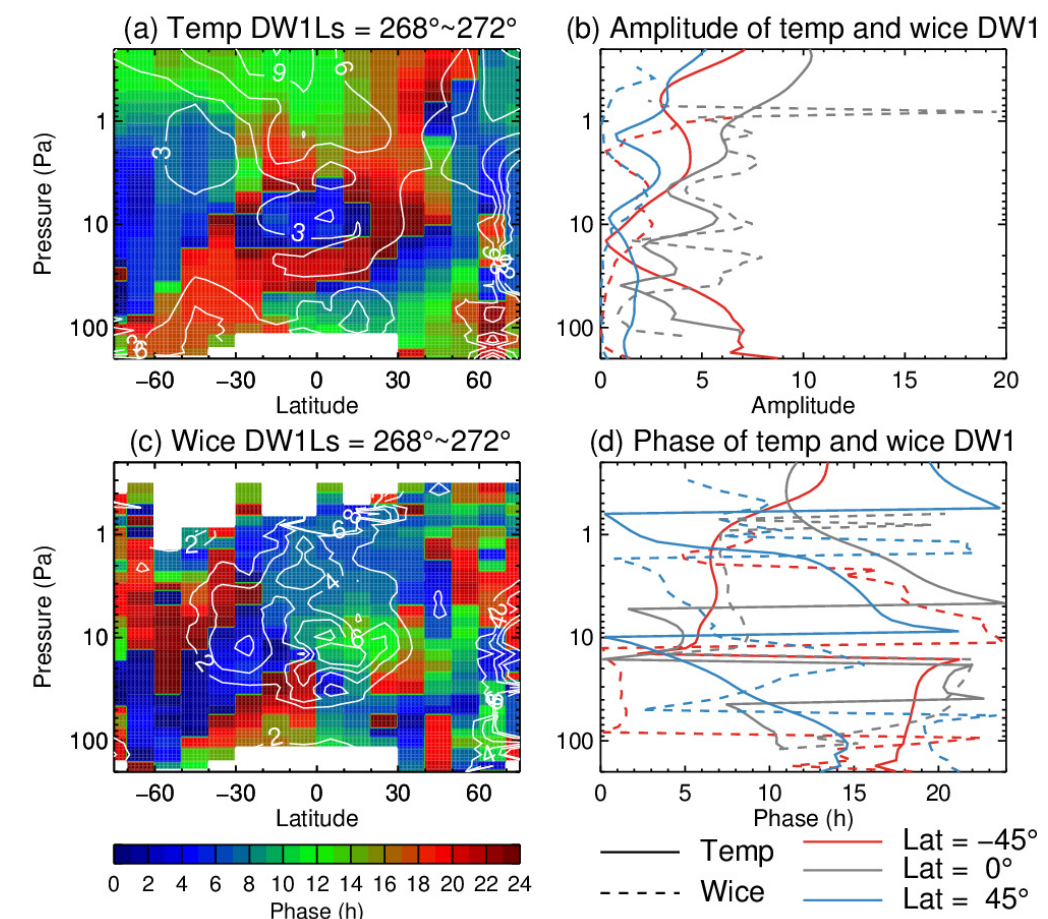
Figure 6. Latitude–altitude structures of ( a ) the temperature and ( c ) water ice DW1 amplitude (white contours) and phase (color shading) at the northern winter solstice. ( b , d ) The comparisons of their amplitude and phase, respectively, at the southern and northern middle latitudes and the equator region. The solid and dashed lines in ( b , d ) indicate the temperature and water ice DW1, respectively, while the colors represent different latitudes. Note that the water opacity value has been multiplied by 10 4 .